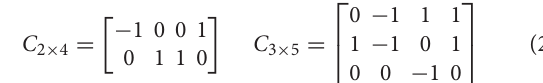
4, N 2 matrix, plotted for the first = = 4, N 2 = = 5, N 3 = =